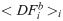
Fluctuations of the CGENM of long DNA sequences.Histograms of (a) < CF
i >i and (b) <DFib>i, and (c) averages and standard deviations of < CF
i >i, < DF
i >i, <DFib>i, <DFis>i, and <DFit>i for 10,000 samples of random 150-bp sequences with an average GC content = 0, 0.1, 0.2, ⋯, and 1. Helical parameter set (i) (Table 2) was used.